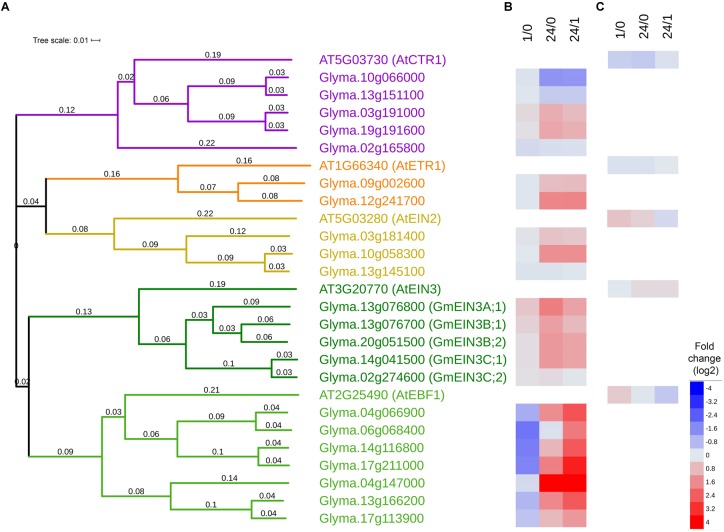
Ethylene signaling pathway genes identified in RNA-Seq from cold treated soybean. (A) Phylogeny tree depicting predicted protein sequences from Arabidopsis [extracted from TAIR (Lamesch et al., 2012)] and soybean [extracted from Soybase (Grant et al., 2010; Severin et al., 2010)] homologs. The colorations on the tree reflect the protein classification with purple indicating serine/threonine-protein kinase, yellow/orange indicating membrane bound, and green indicating transcription factors. (B) Heatmap of log2 fold changes comparing soybean cold responses (4°C) 1 vs 0 h (1/0), 24 vs 0 h (24/0), and 24 vs 1 h (24/1) from RNA-Seq data (from Yamasaki and Randall, 2016) where blue indicates decreases and red indicates increases in comparison. The averaged read counts with SDs are in Supplementary Table S1. (C) Heatmap of log2 fold changes comparing cold responses (4°C) of the aerial portions of Arabidopsis 1 vs 0 h (1/0), 24 vs 0 h (24/0), and 24 vs 1 h (24/1) from microarray data from Kilian et al. (2007) where blue indicates decreases and red indicates increases in comparison.